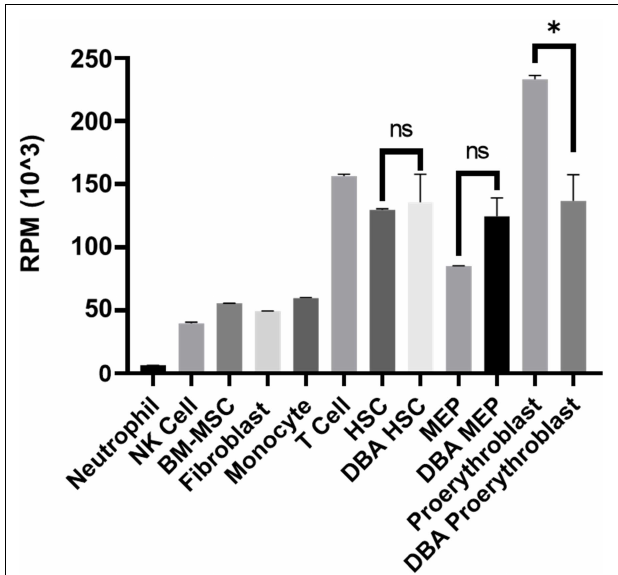
FIGURE 4 | Total ribosomal protein mRNA expression of different cell types. Different cell types analyzed with the same transcriptomic approach from the in-house dataset were evaluated. RPM: reads per million, NK: natural killer, BM-MSC: bone marrow mesenchymal stem cells. HSC: hematopoietic stem cell, MEP: Megakaryocyte–Erythroid Progenitor Cell, ns: non-significant. ∗ p value <